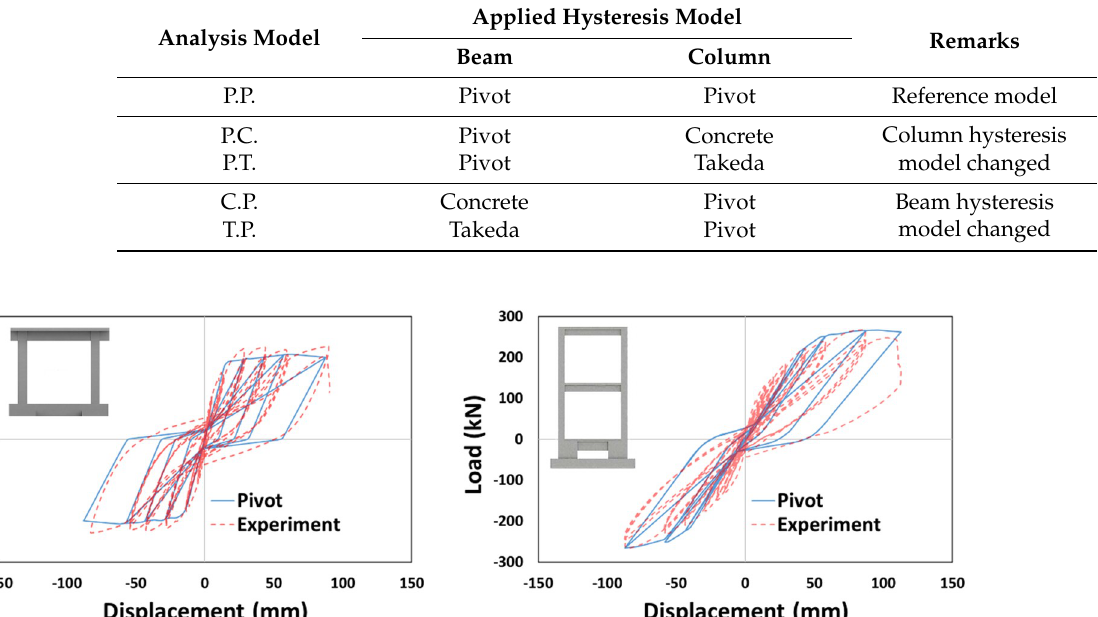
Table 2. Description of the analysis models considered by type.